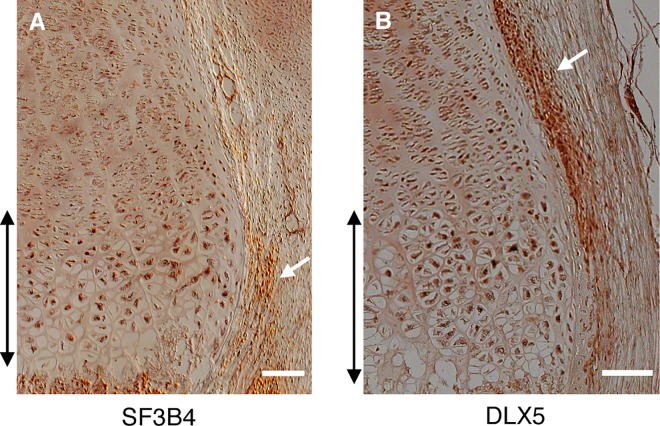
SF3B4 and DLX5 are co-expressed in the human growth plate.Immunohistochemical staining of the distal femur growth plate from a control fetus with (A) anti-SF3B4 and (B) anti-DLX5 antibodies. The hypertrophic zone is marked with double arrows. The periosteum is identified by white arrows. Images were obtained at 20X (SF3B4) and 10X (DLX5) magnification. Scale bars are 100 μM.